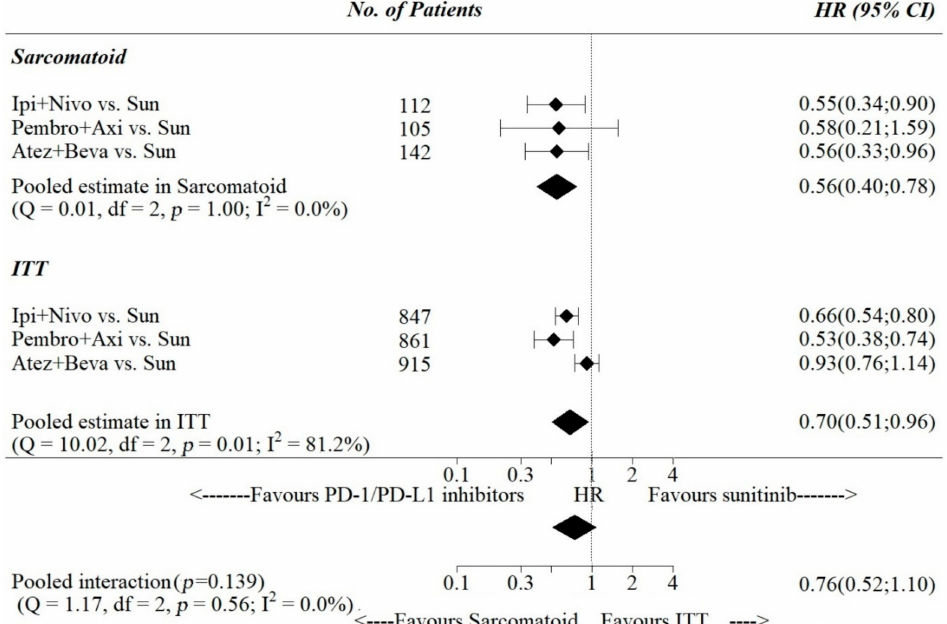
Figure 4. Interactions between HR for death and sarcomatoid